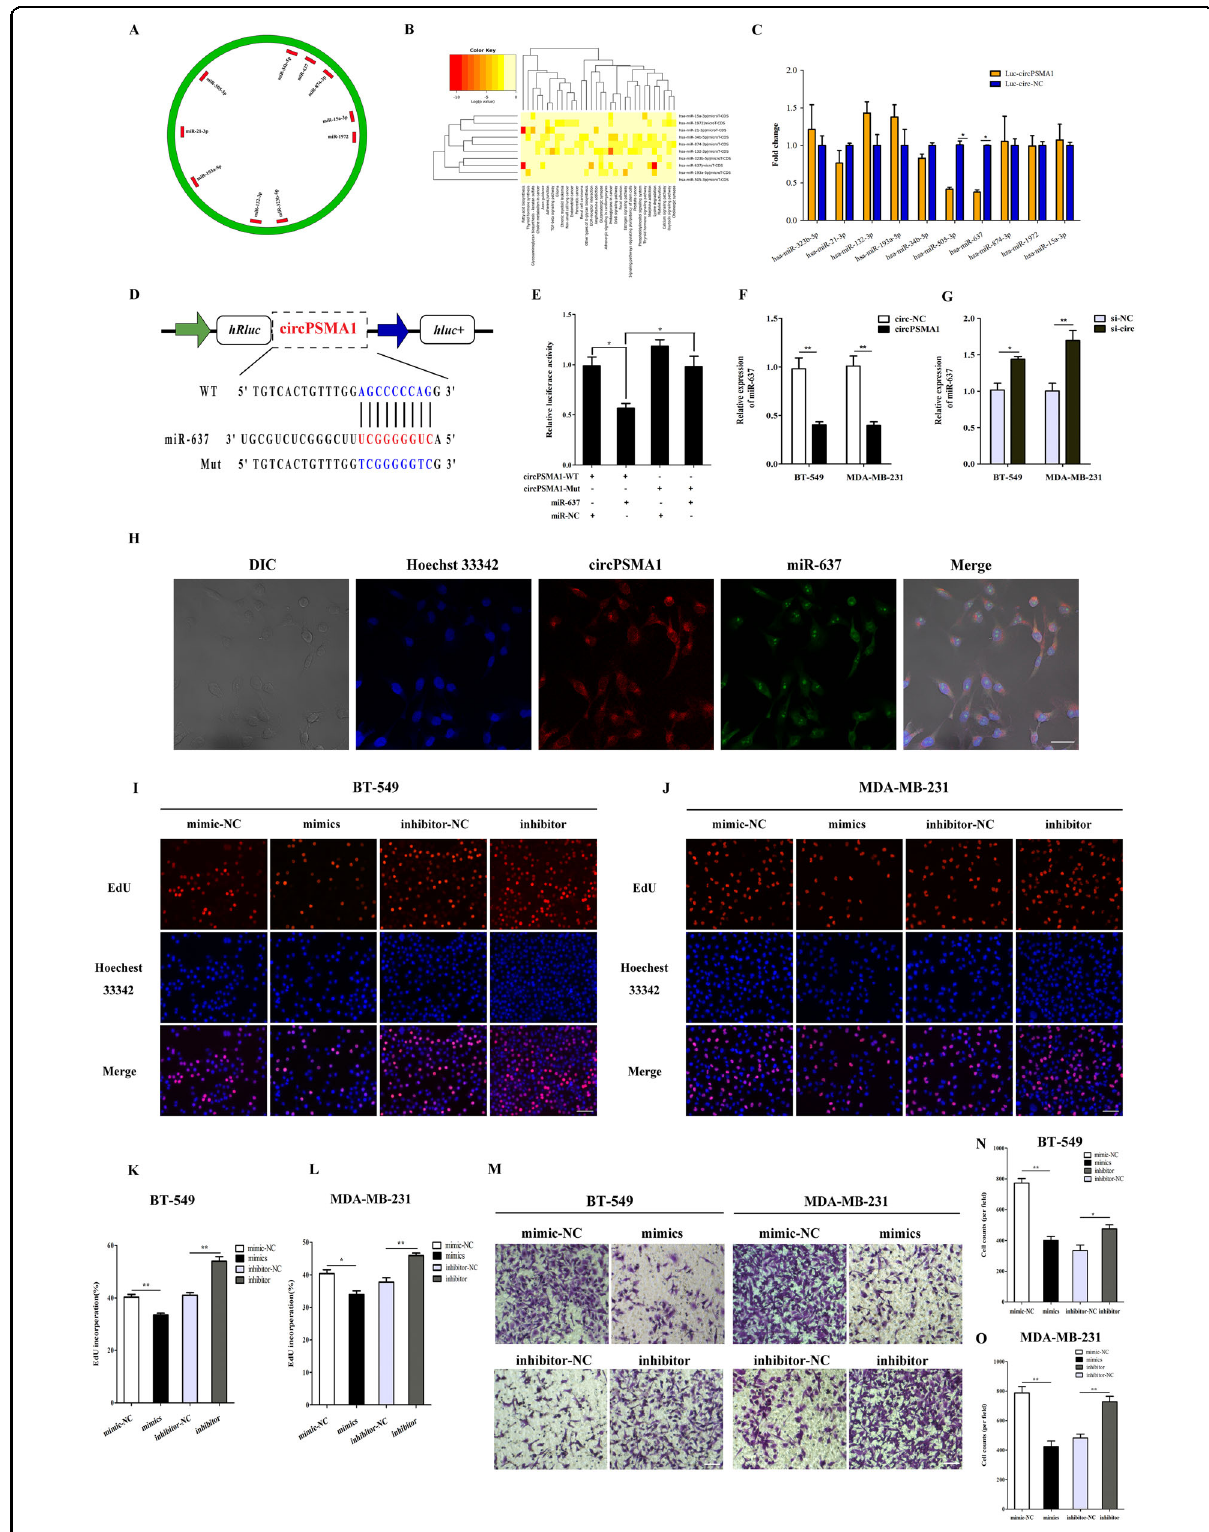
Fig. 3 (See legend on next